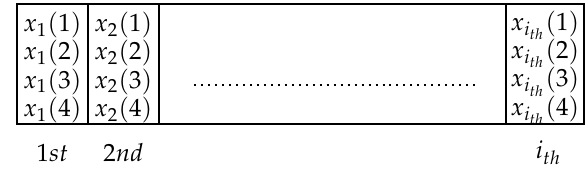
Figure 2. Structure of population for an